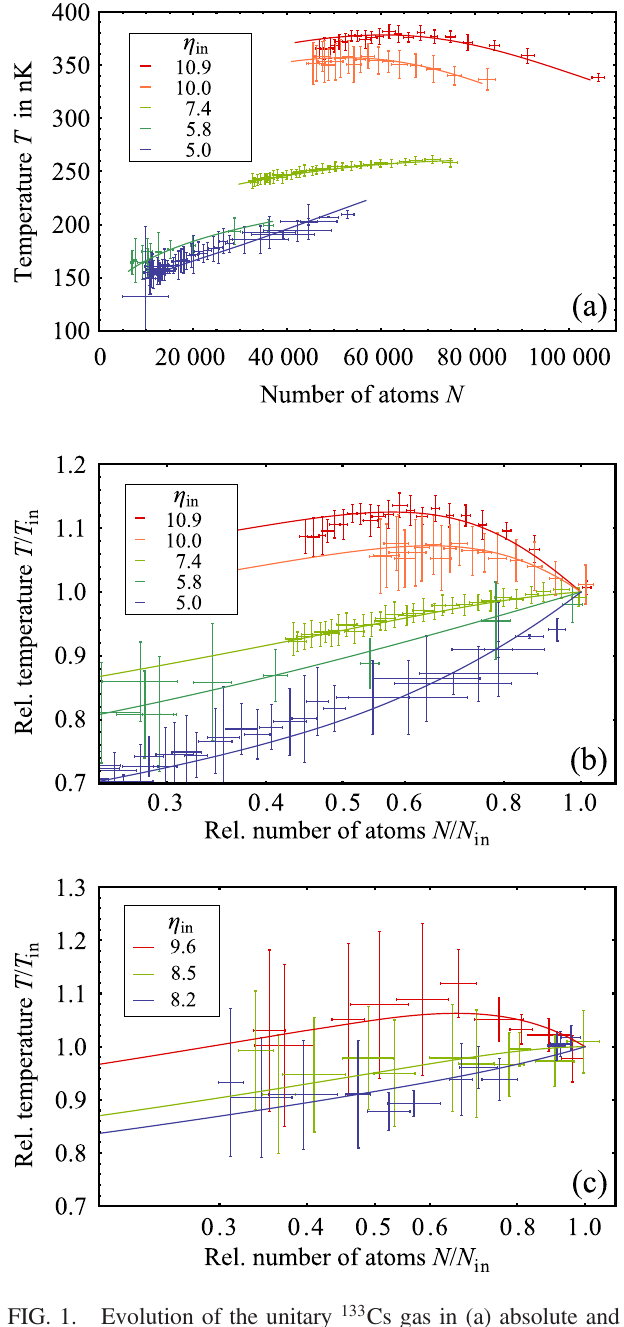
FIG. 1. Evolution of the unitary 133 Cs gas in (a) absolute and (b) relative numbers (points). The solid lines are fits of the data using the theory presented in Sec. III, and the fitted initial relative U=k T is given in the legend. The condition trap depth η in ¼ B in ≈ η ≈ 8 . 2 , very close to the is expected for η for ð d T= d N Þj in m t ¼ 0 7 . 4 [green lines in (a) and (b)]. measured data for η in ¼ (c) Evolution of the unitary 7 Li gas. The solid lines are fits of the data using our 2D evaporation model and the fitted initial ≈ η eff as in (b). In 2D evaporation, η relative trap depth η in in m ¼ 1 ¼ 8 . 5 is required to meet the ð d T= d N Þj η condition and m þ t ¼ 0 is found to be in good agreement with the measured value 8.5 [green line in (c)]; see text. All error bars represent 1 standard